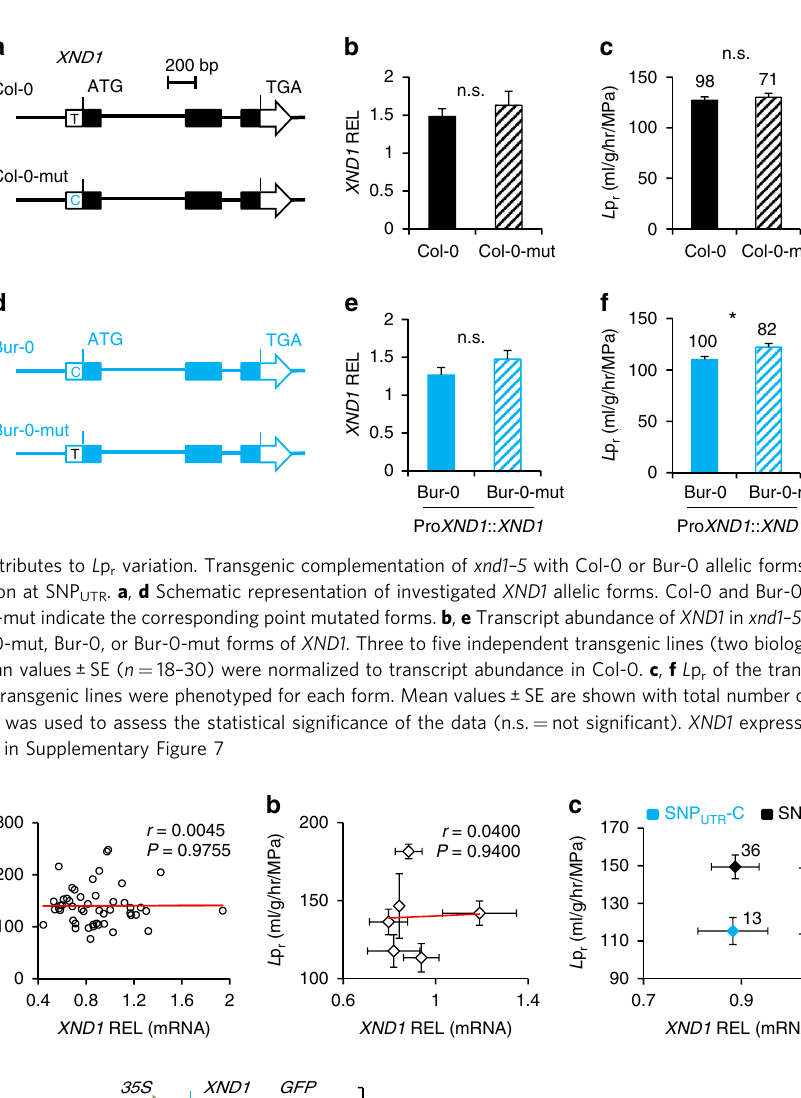
we used sodium azide (NaN 3 ), a common blocker of plant plasma membrane aquaporins 3,19 . NaN 3 dramatically reduced L p r in Col-0 and three T-DNA insertion xnd1 genotypes, yielding a residual L p r , which was higher in loss-of-function alleles ( xnd1 – 3 , xnd1 – 5 ) than in wild type (Col-0) or gain-of-function ( xnd1 – 4 )